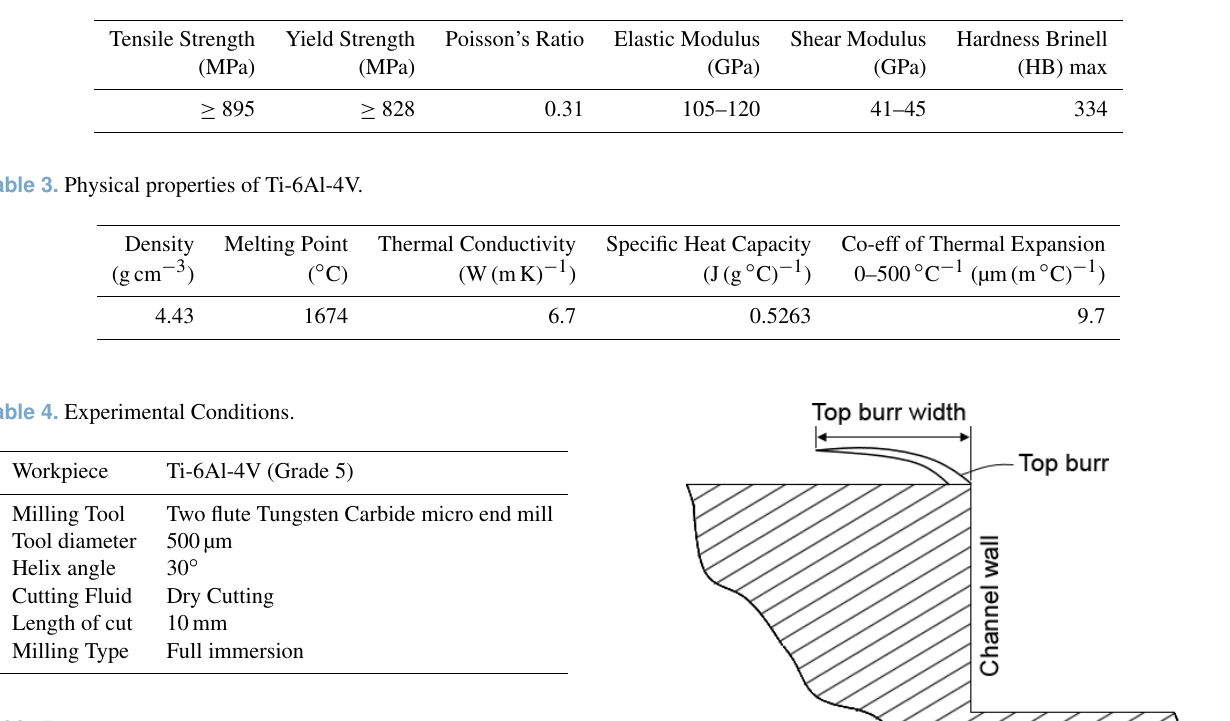
Table 2. Mechanical properties of Ti-6Al-4V.